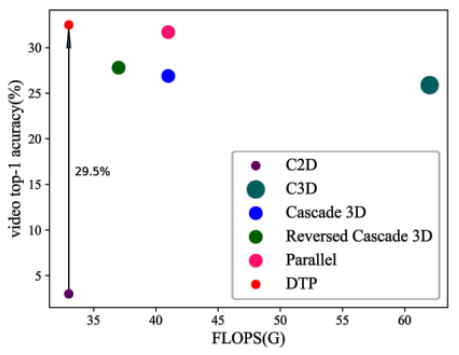
Figure 5. Training and testing errors for DTP and Parallel on Something-Something V1.